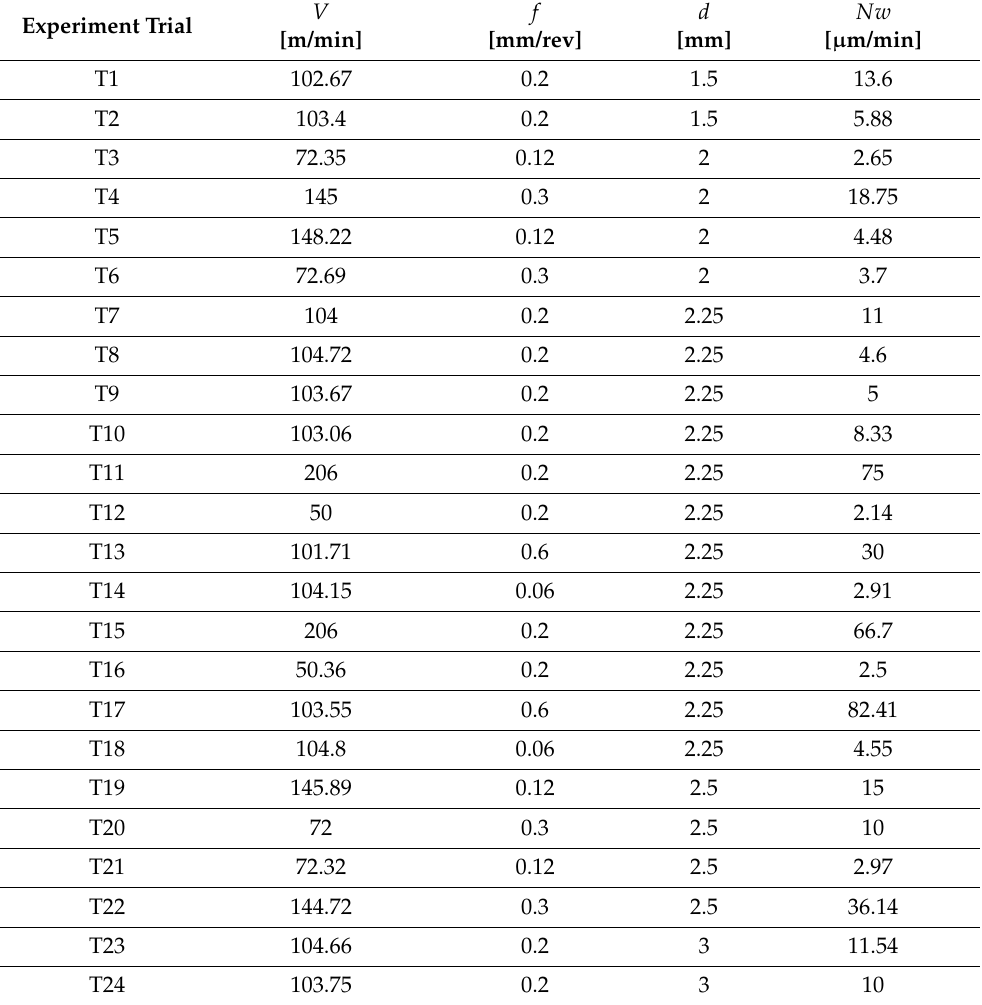
Table 2. The experimental